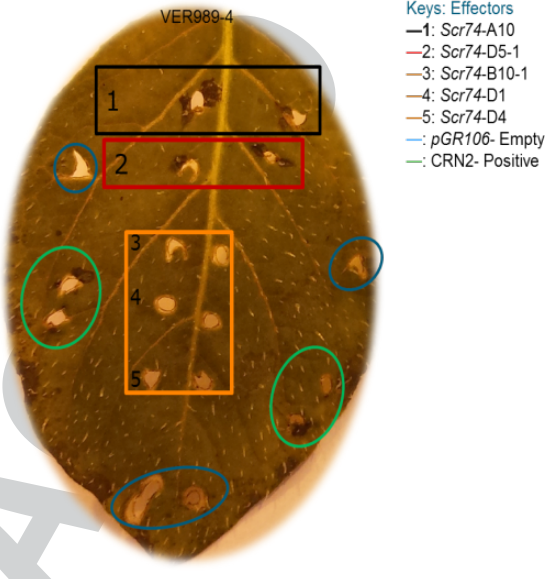
Figure 4. Hypersensitive response triggered by recognition of Scr74 - A10 and Scr74 -D5_1 in S. verrucosum accession VER989-4. Results were obtained via effectoromics assay with PVX